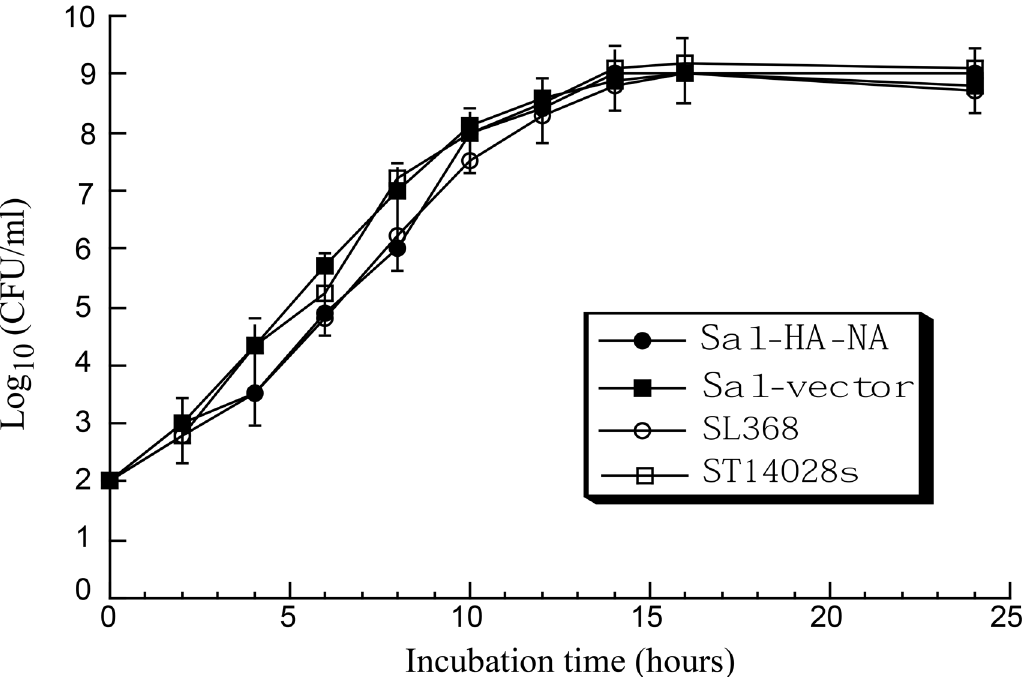
Fig 1. Analysis of growth in LB broth of Salmonella . Salmonella used in the study include the wild type strain ST14028s, mutant strain SL368, and its derivatives that carry the empty vector construct pVAX1 (Sal-vector), and constructs p5HA and p5NA (Sal-HA-NA). Experimental details can be found in Materials and